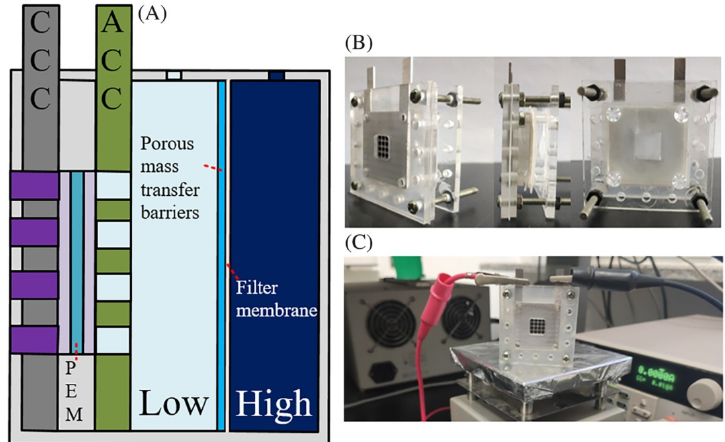
Figure 10. PS-DMFC with anode dual-cavity structure: ( A ) schematic diagram; ( B ) picture of the assembled device; ( C ) picture of the experimental setup. Reproduced from [124] with permission from John Wiley and Sons 2021.